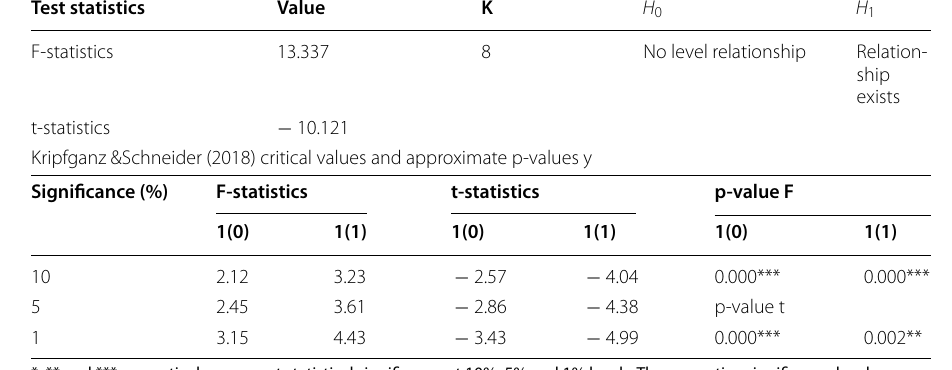
*, ** and *** respectively represent statistical significance at 10%, 5% and 1% levels. The respective significance levels suggest the rejection of the null hypothesis of no cointegration. The optimal lag length on each variable is chosen by the Schwarz’s Bayesian information criterion